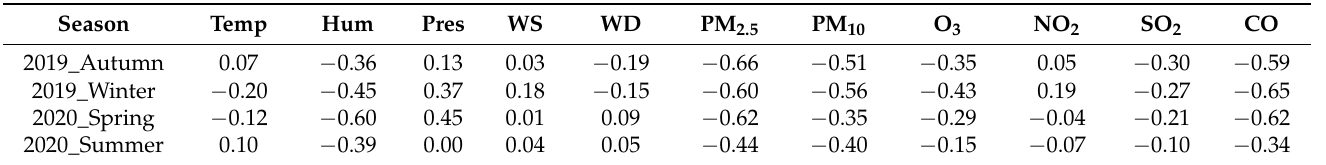
Table 2. Correlation coefficients between seasonal average visibility and various types of features in Qingdao.